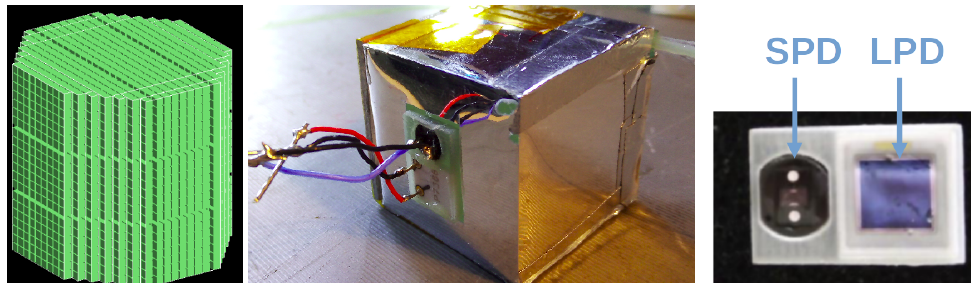
Figure 1. On the left: scheme of the structure of the calorimeter, about 7500 LYSO cubic crystals are assembled in an octagonal-based prism. In the center: picture of a LYSO crystal with WLSF and PD read-out systems installed; the crystal is covered with a reflective coating. On the front side of the crystal a monolithic package with photodiodes is glued to the crystal. The WLSFs are glued on the top face of the crystal, but are covered by the reflective coating; however, we can see the fibers coming outside of the reflective coating in the upper right corner of the image. On the right: an illustration of an in-house-built prototype of a monolithic package for the PD read-out